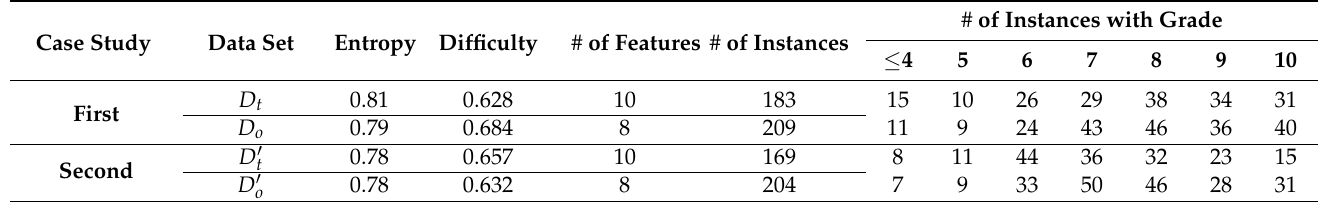
Table 6. Description of the data sets.